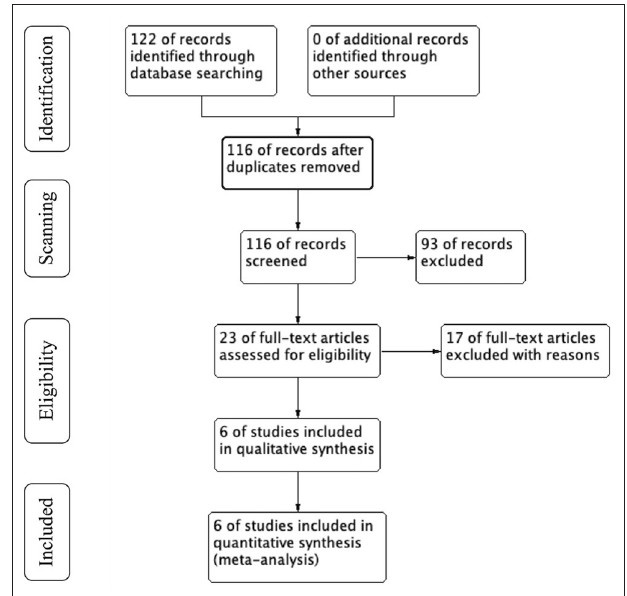
FIGURE 1 | PRISMA flow